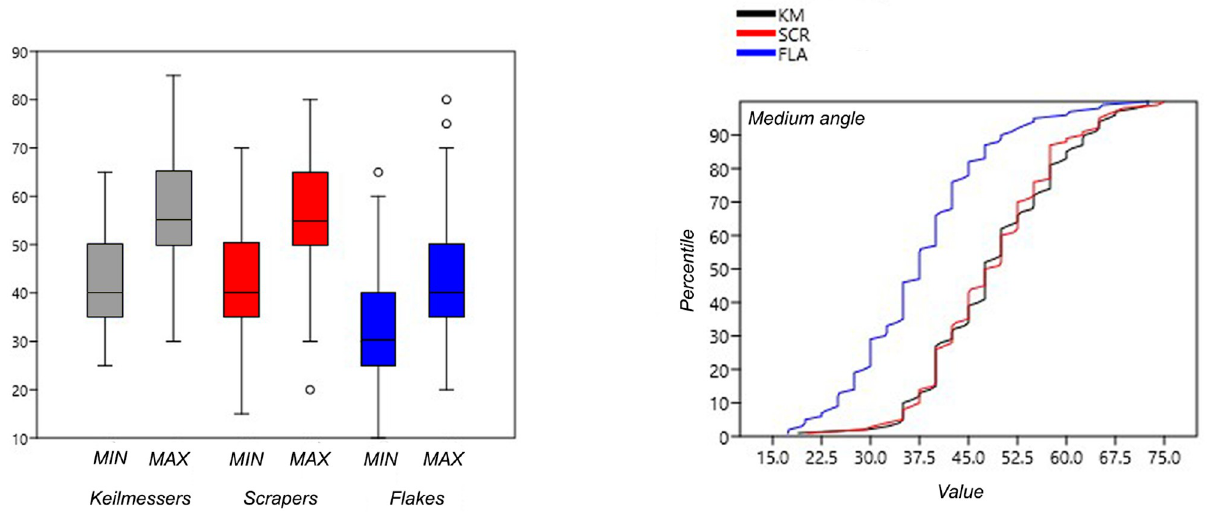
Fig 11. Boxplot and percentile charts showing the distribution of cutting edge angles among tool types (“KM”: Keilmesser; “Scr”: scrapers; “Fla”: flakes).